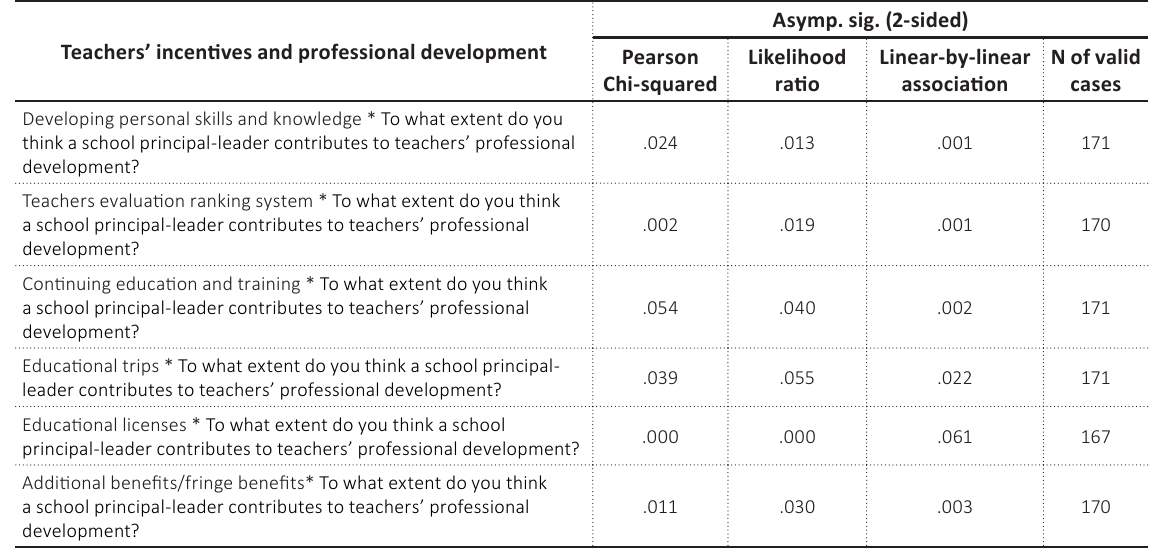
Table 7. Chi-squared analysis for hypothesis H